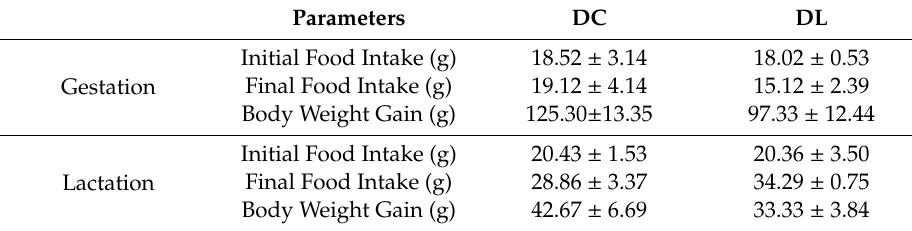
Table 1. Dam food intake and weight gain during the gestation and lactation periods.